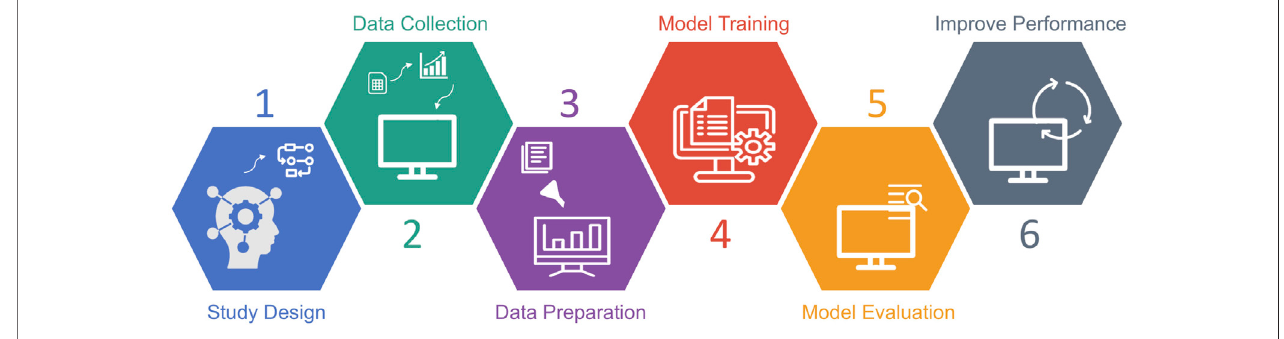
FIGURE 2 | Work fl ow of machine learning